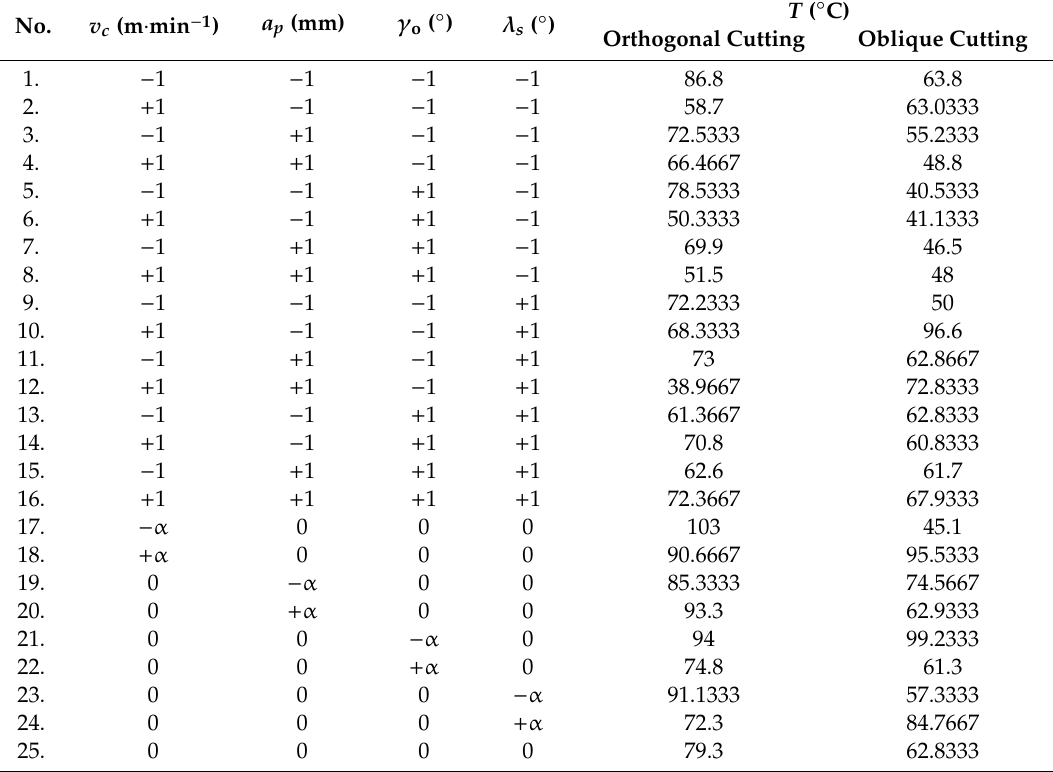
Table 8. Experimentally obtained values of temperature in cutting zone for orthogonal and oblique machining of EN 16MnCr5